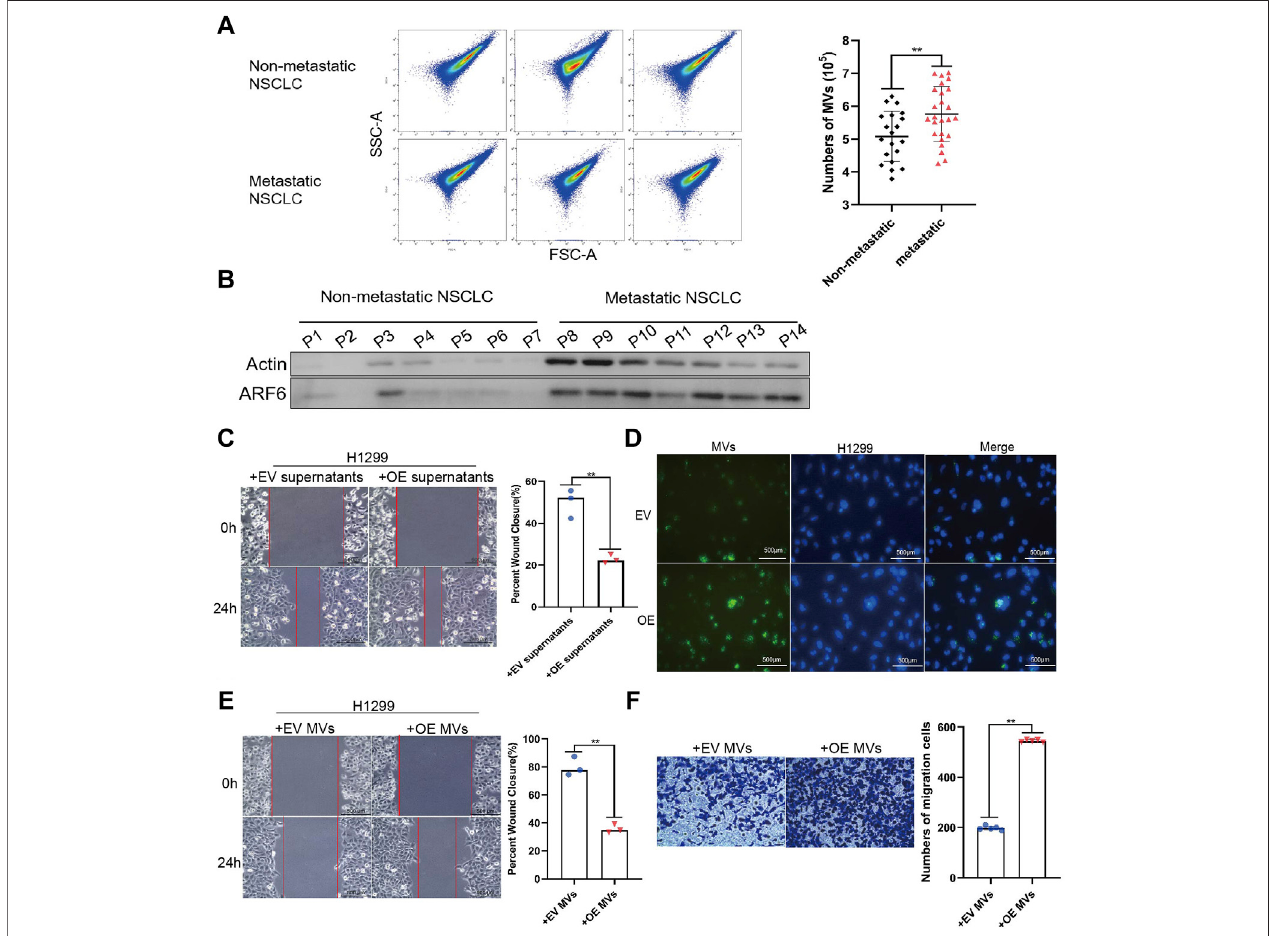
FIGURE 3 | MVs derived from PFN1 OE cells promote migration in NSCLC cells. (A) MVs collected from sera of patients with NSCLC quanti fi ed using fl ow cytometry.** p < 0.01. (B) ProteinexpressionofARF6and β -actininMVscollectedfromseraofpatientswithNSCLCdetectedusingwesternblotting. (C) Effectof PFN1 - overexpressing cell supernatants on cell migration evaluated through wound healing assays. ** p < 0.01; scale bar,500 μ m. (D) PKH67-labeled MVstakenup byH1299 cells. DAPI was used to stain the nuclei of H1299 cells. Scale bar, 500 μ m. (E,F) Wound healing (E) and Transwell migration (F) assays conducted to evaluate the migration of H1299 cells after treatment with MVs derived from EV-expressing and PFN1 -overexpressing cells; ** p < 0.01; scale bar, 500 μ m.